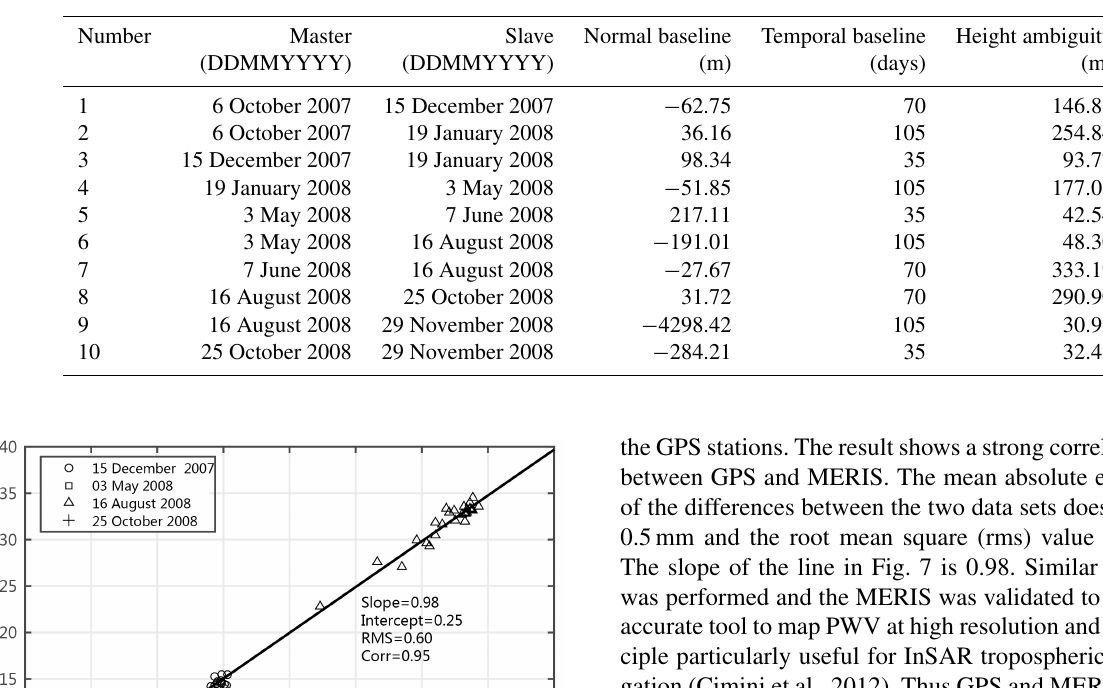
Table 1. Acquisition dates of master and slave images and their parameter information.